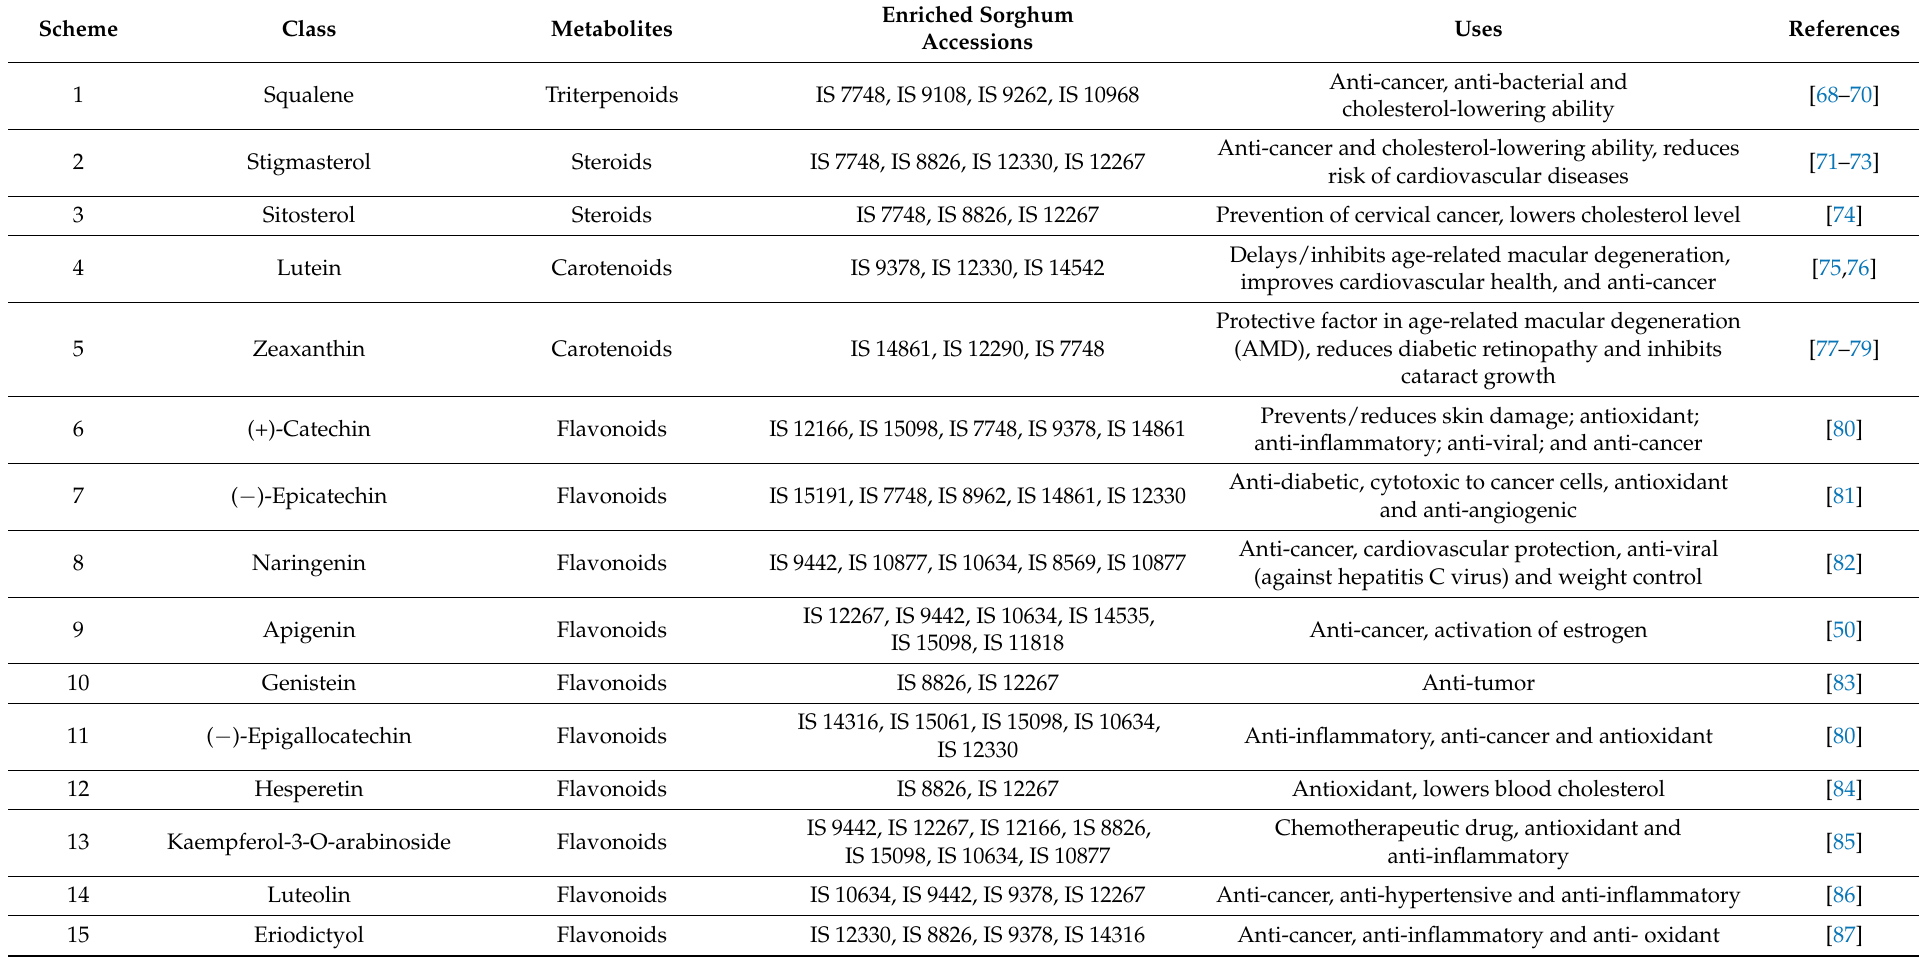
Table 3. List of accessions enriched with nutraceutical and therapeutic metabolites and their potential